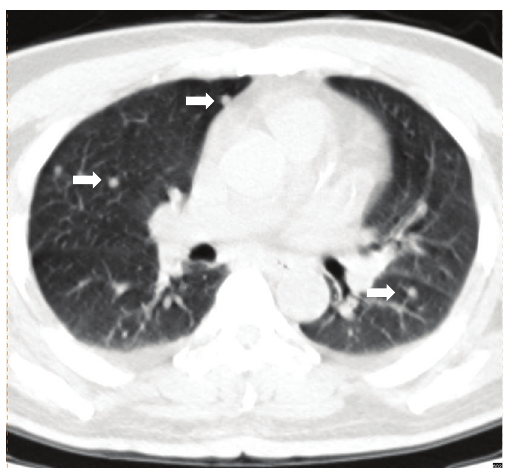
Figure 1: CT image from a 48-year-old male patient diagnosed with hepatocellular carcinoma. The followup unenhanced CT of 18 F-fluoride PET/CT, in the lung window, revealed numerous tiny pulmonary nodules in the bilateral lungs (arrows). The largest nodule was 0.6cm in size and none of these nodules were visualized by concurrent chest X-ray.